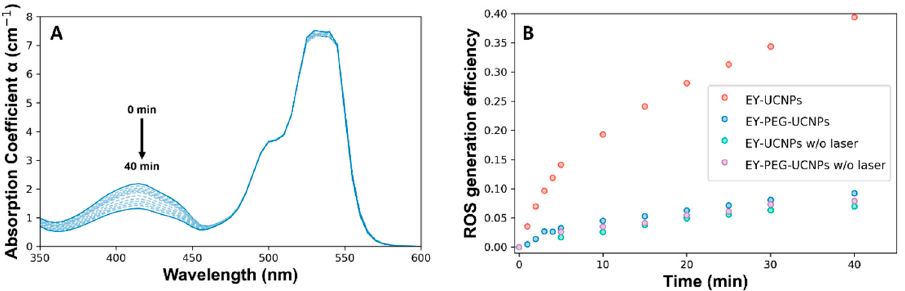
Figure 5. ( A ) Change in the absorption band after irradiation of nanoconjugate dispersions and DPBF with a 790 nm laser for 40 min. ( B ) ROS generation efficiency of EY-UCNPs and EY-PEG-UCNPs with (black and red) and without (yellow and green) 808 nm laser irradiation at different irradiation times.